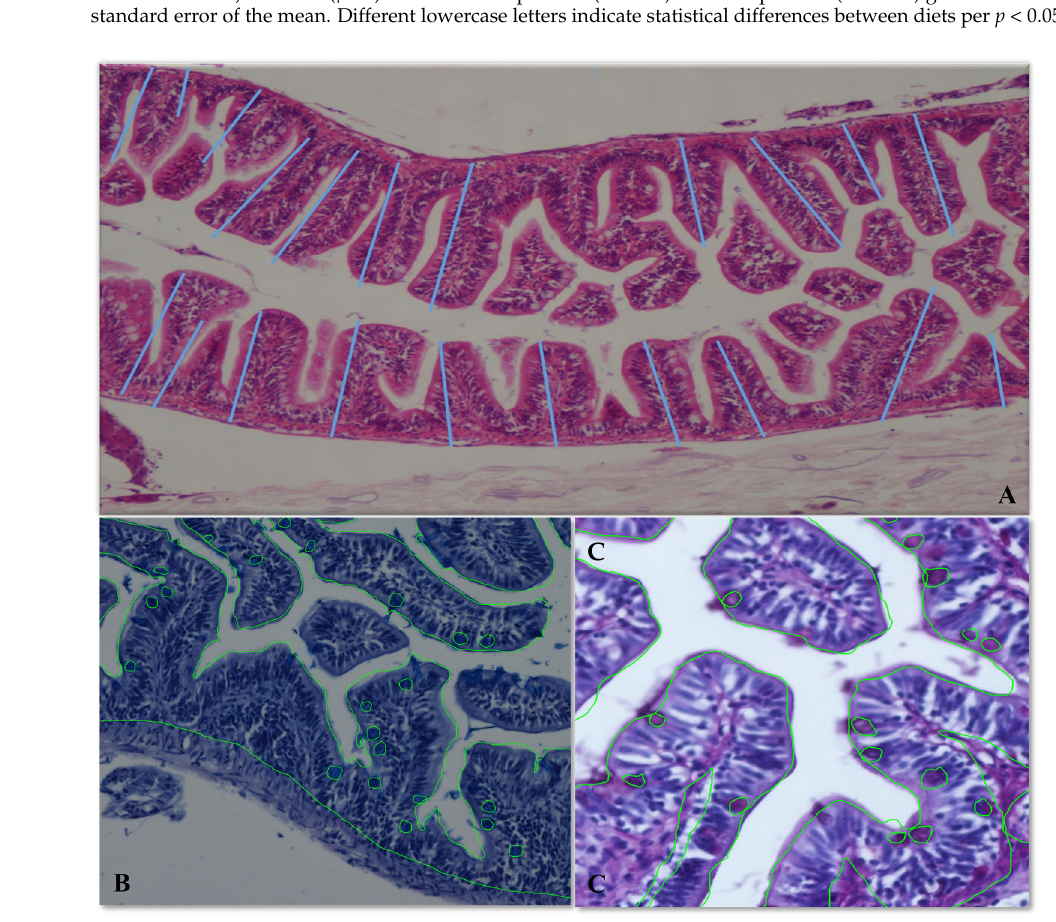
Figure 1. Portions of Zebrafish intestinal lumen: ( A ) blue lines indicate the villus length measured from its apex to the tunica serosa, green circles indicate ( B ) Alcian blue positive goblet cells and ( C ) PAS-positive goblet